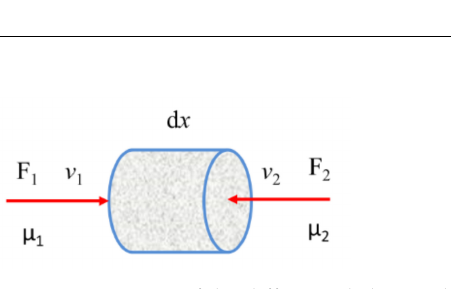
Figure 2. Diagram of the differential element before the deformation of